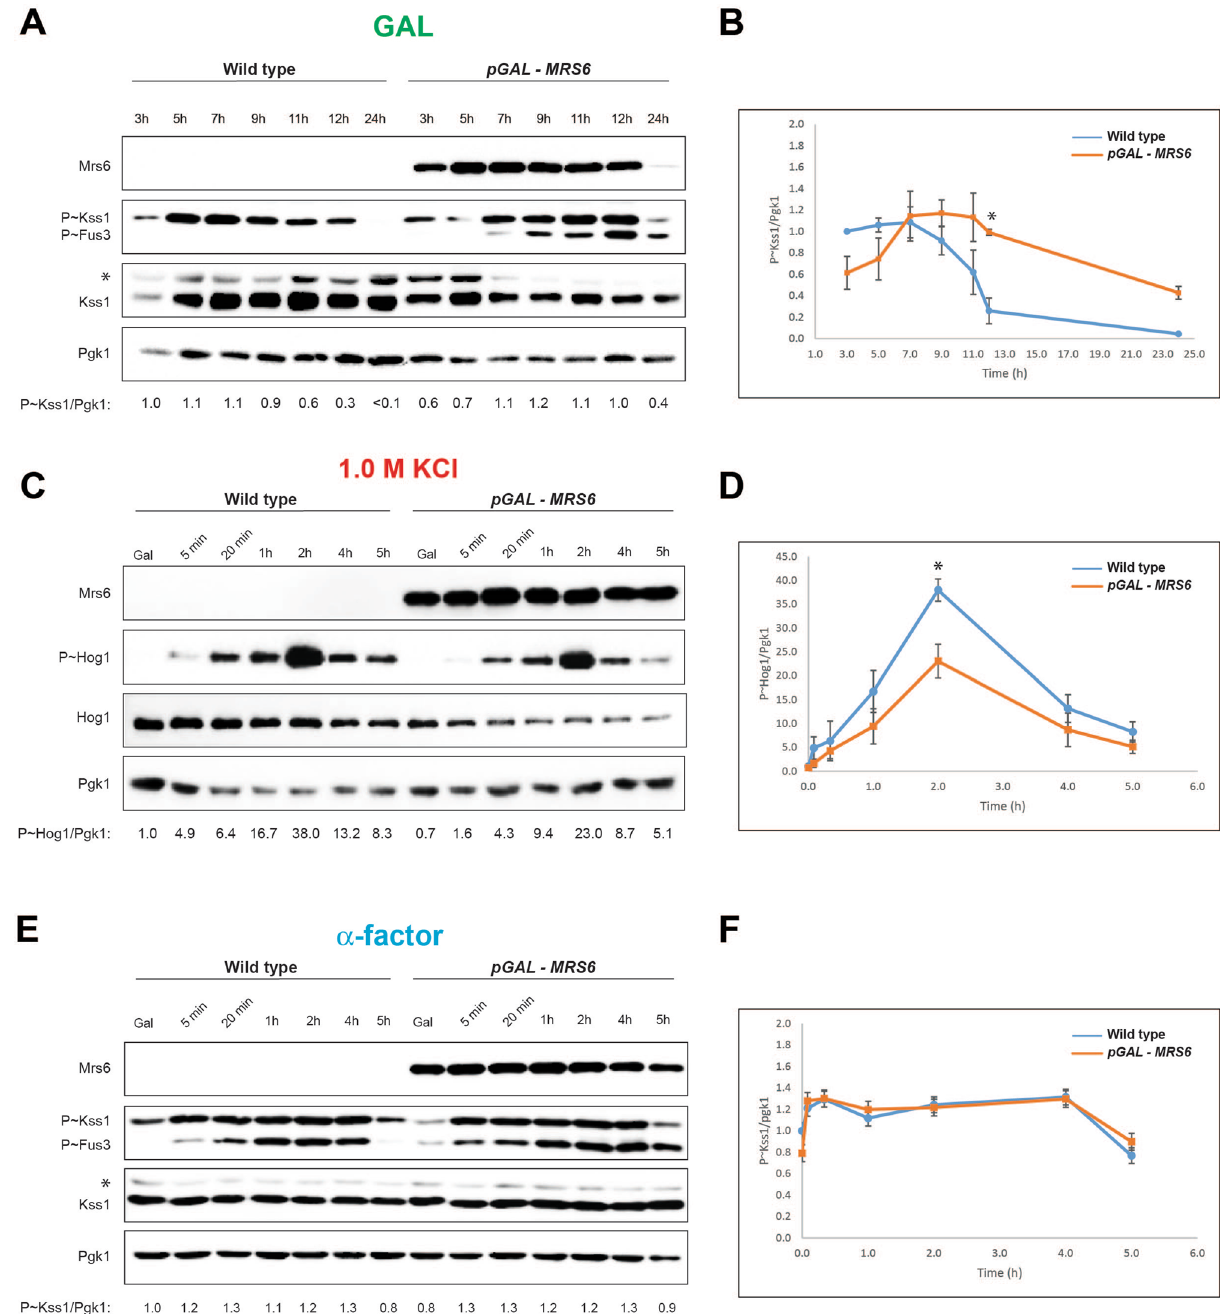
Figure 6. Impact of overexpression of MRS6 on the fMAPK, HOG, and mating pathways. Wild-type cells (PC6810) and cells overexpressing MRS6 (PC7447) were examined under conditions that induce MAPK pathway signaling. Cell extracts were evaluated by MAP kinase phosphorylation by immunoblot (IB) analysis. One example is shown for panels A, C, and E (raw data is shown in Fig. S3 A, B, and C, respectively). For panels B, D, and F, the data represent the average of at least three independent experiments. Error bars indicate the standard error of mean between trials (Asterisks, p-values < 0.05 by student’s t-test). ( A ) Cells were grown in the non-preferred carbon source galactose (YEP-GAL) for the times indicated. Cell extracts were examined by IB analysis for P ~ Kss1 and P ~ Fus3 by p44/42 antibodies. Mrs6 proteins were detected at ~ 91 kDa. Total Kss1 levels and Pgk1 (loading control, ~ 45 kDa) also were assessed. The ratio of P ~ Kss1 to Pgk1 normalized to wild-type values, which were set to a value of 1. ( B ) Graph visualizes the ratio of P ~ Kss1 to Pgk1 for wild-type and pGAL-MRS6 . (C) Cells were pre-grown in YEP-GAL for 4 h following by growing in YEP-GAL medium containing 1.0 M KCl to examine P ~ Hog1. ( D ) Graph showing P ~ Hog1 to Pgk1 ratios, normalized to wild-type values, which were set to a value of 1. ( E ) Phosphorylation of Kss1 and Fus3 in response to pheromone. Cells were grown in YEP-GAL for 4 h, and incubated in YEP-GAL medium containing 1 mg/ ml α-factor for the times indicated. Fus3 bands run in the same size as a degradation product of MRS6 . ( F ) Graph showing P ~ Kss1 to Pgk1, normalized to wild-type values, which were set to a value of